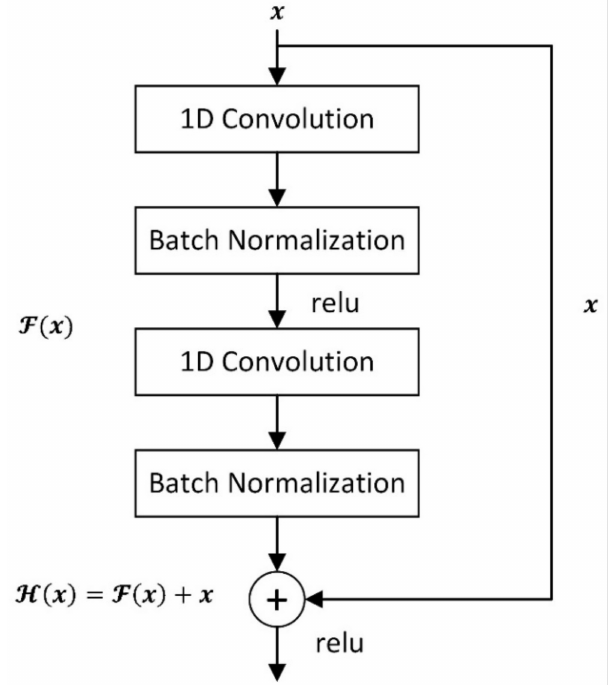
Figure 2. The residual learning